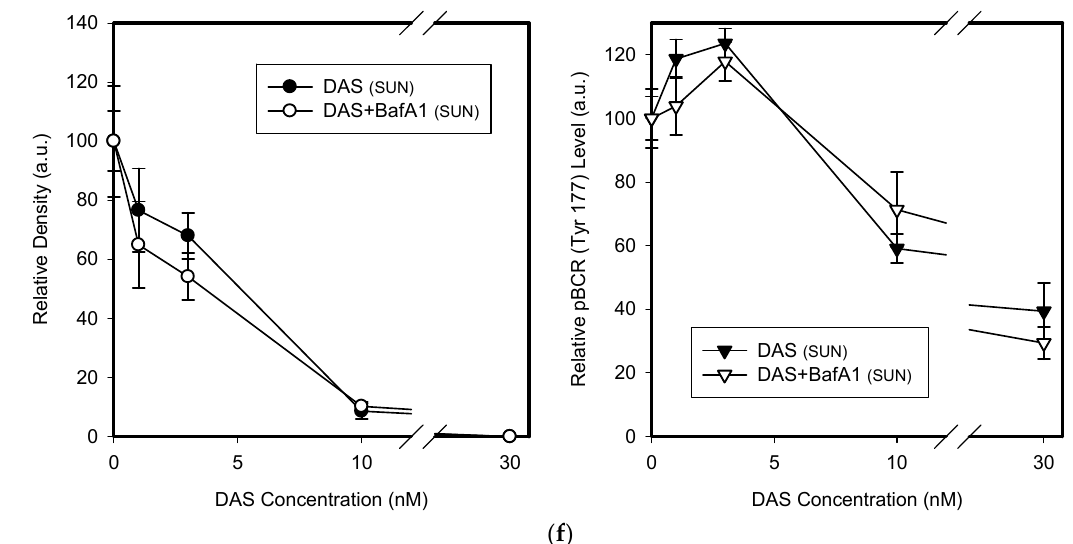
Figure 9. The effect of the lysosomal sequestration of IM on Bcr-Abl signaling in SUN-stimulated cancer cells. SUN-stimulated cells were incubated with various TKIs concentration in the absence or presence BafA1. After 6 h, cell extracts were analyzed for the CrkL phosphorylation (Tyr207) and Bcr-Abl phosphorylation (Bcr (Tyr177)) using western blot analysis. ( a ) Cells incubated wit IM ± BafA1 (typical analysis). ( b ) Quantitative analysis of western blots using densitometry. ( c ) Cells incubated wit NIL ± BafA1 (typical analysis). ( d ) Quantitative analysis of western blots using densitometry. ( e ) Cells incubated wit DAS ± BafA1 (typical analysis). ( f ) Quantitative analysis of western blots using densitometry. Columns represent the means and standard deviations of four independent experiments.